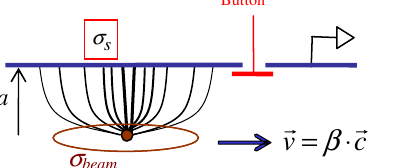
FIG. 6. (Color) A single charged particle moving at (cid:1)c creates an electrical field at the chamber wall of a longitudinal distri- ffiffi ¼ a p , where (cid:6) is the relativist factor and a is the bution (cid:5) S 2 (cid:6) radius chamber